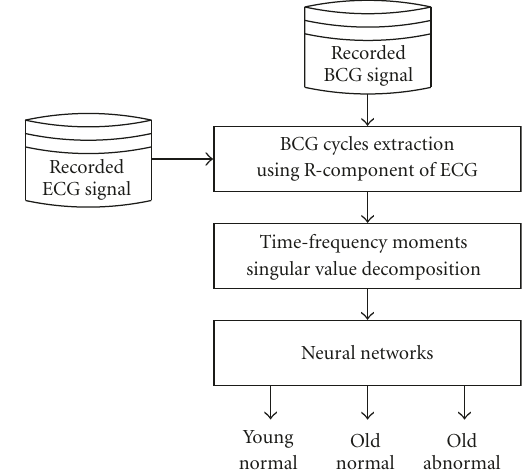
Figure 4: Block diagram of the post-recording signal